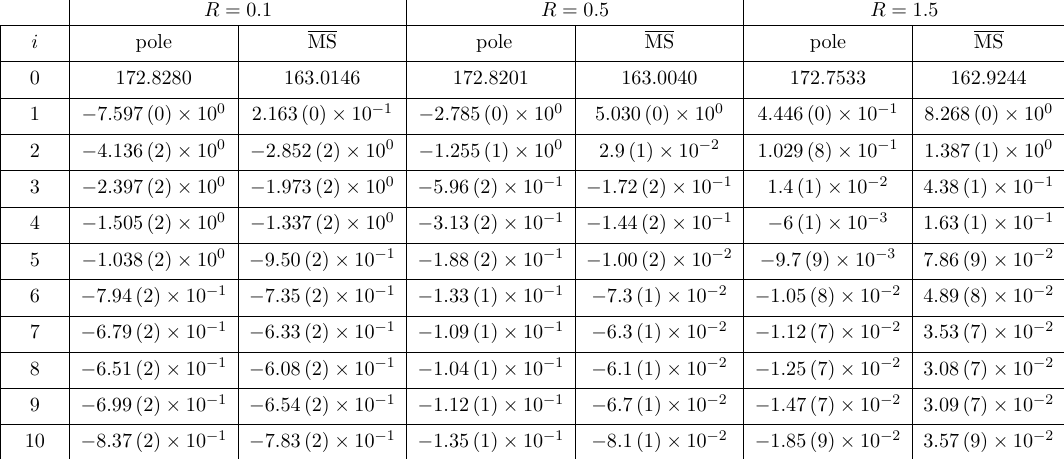
Table 5 . Values of the c i (cid:11) i terms of the perturbative expansion for the average value of the S reconstructed-top mass, de(cid:12)ned in eq. (8.5), for three di(cid:11)erent jet radii, in the pole-mass and MS- mass scheme. The errors reported in parenthesis are due to the uncertainty on the linear coe(cid:14)cient of the (cid:12)t (i.e. p 1 in eq.